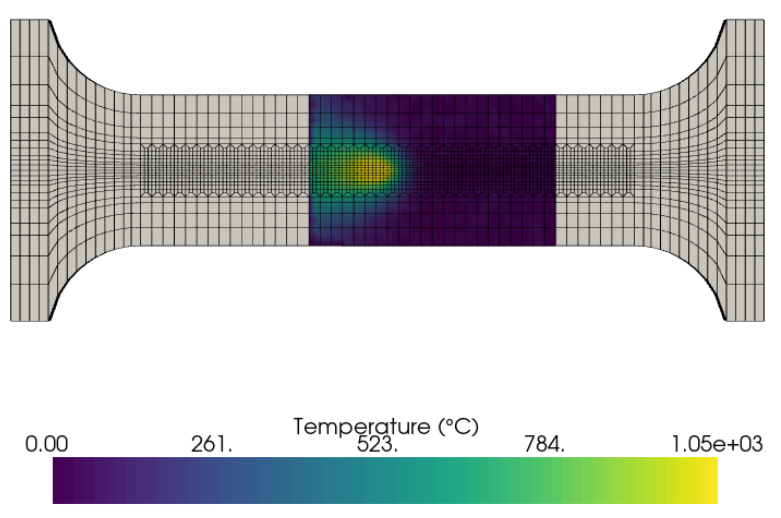
Figure 7. Noisy simulation data on camera area.